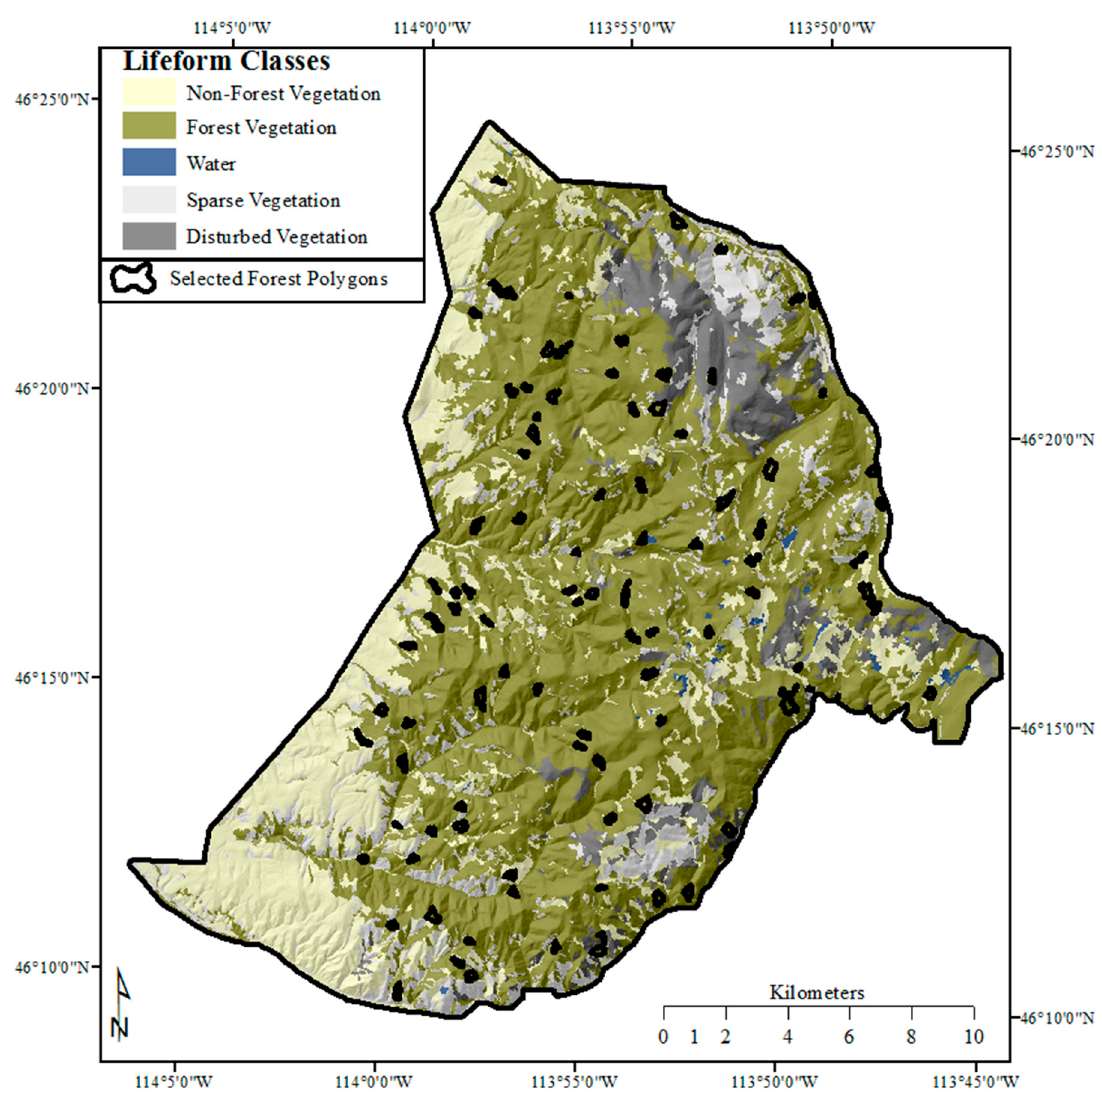
Figure 4. Daly-Gold Study Area lifeform classification with randomly selected forest polygons highlighted in black. Summarized metric predictions were compared in these polygons.